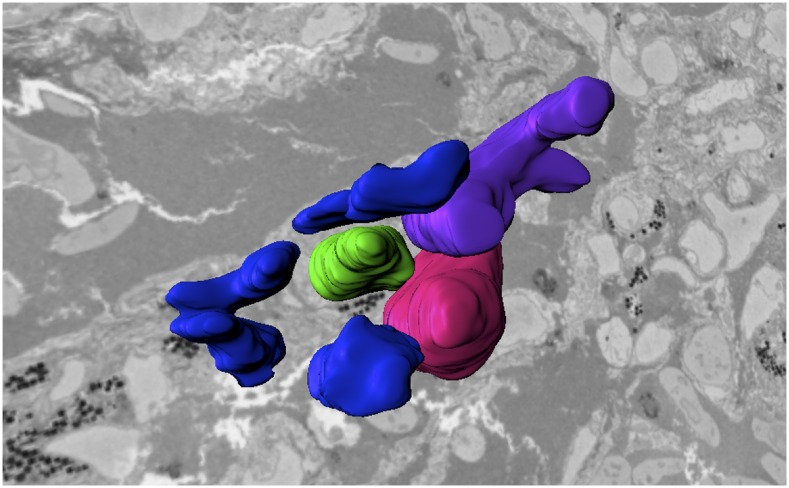
High-Resolution Electron Microscopy of Endogenous Hematopoietic Stem and Progenitor Cell (HSPC) in the Perivascular Niche. Lodged HSPC (green), surrounding EC (electron capture) nuclei (blue, numbered), and stromal cells (pink and purple). Reprinted from Tamplin et al. (2015), with permission from Elsevier.